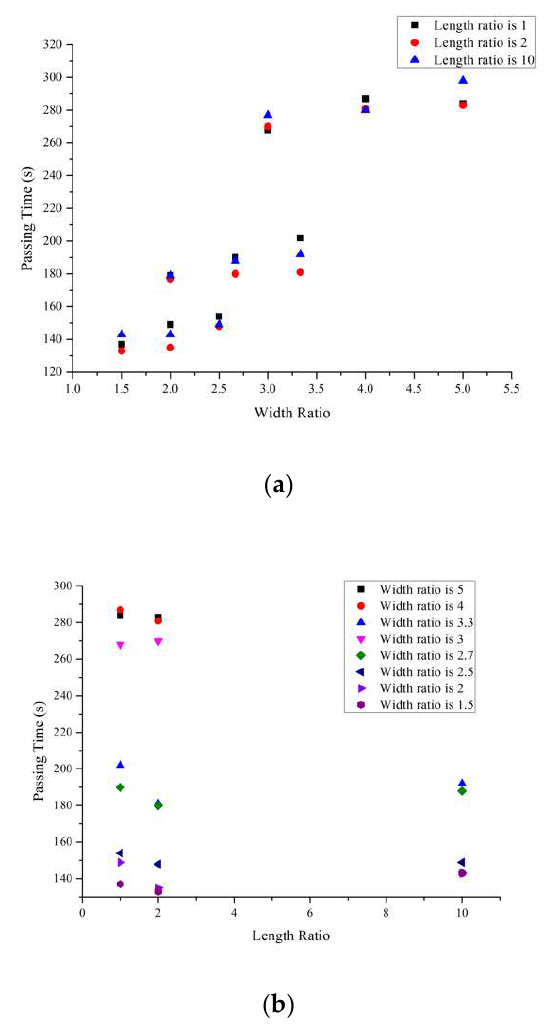
Figure 7. Relations between bottleneck scenario and passing time. ( a ) scatter diagram of width ratio and passing time and ( b ) scatter diagram of length ratio and passing time.